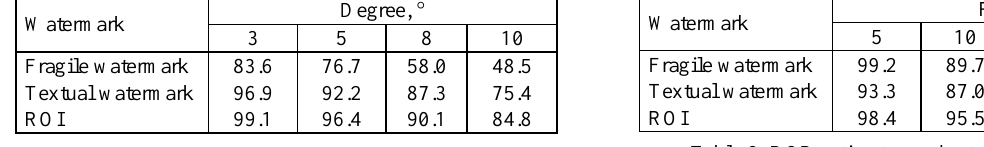
Table 1. BCR estimates under rotation attacks